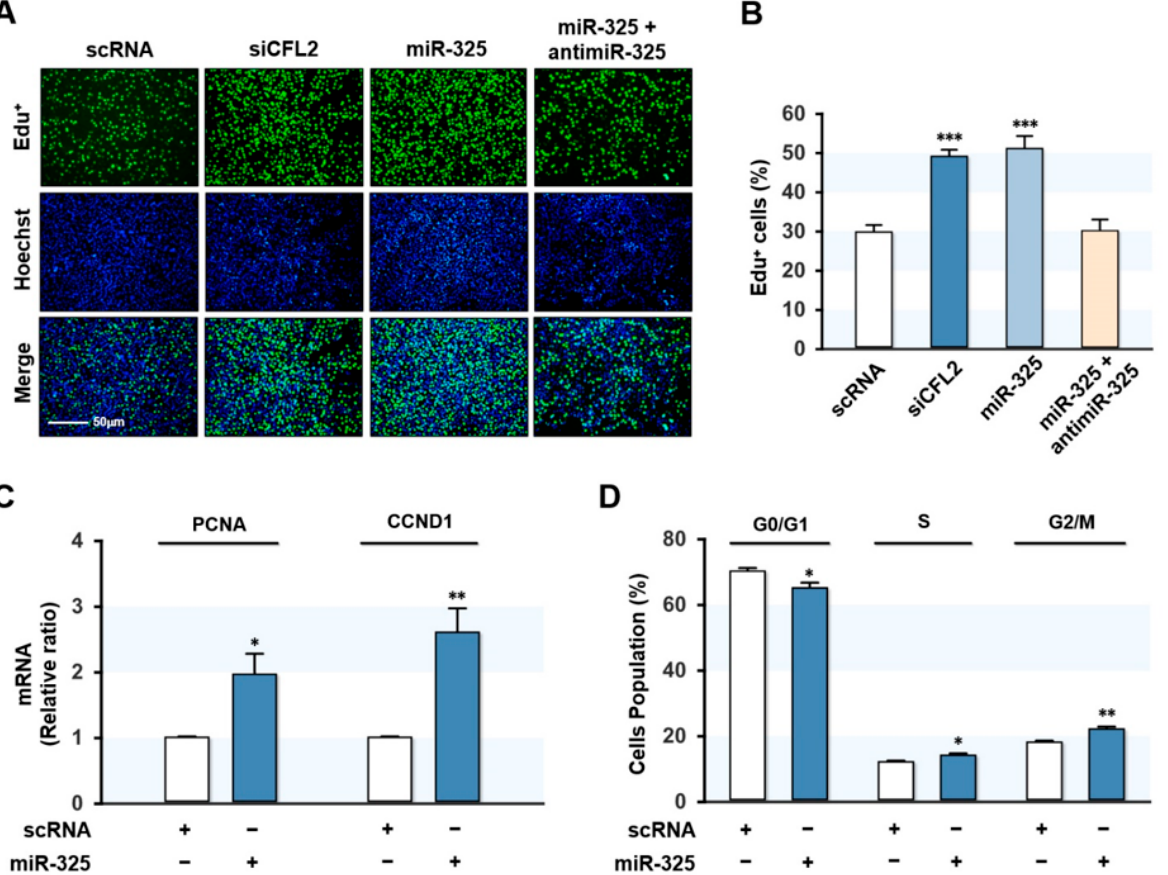
Figure 4. MiR-325-3p promoted myoblast proliferation and cell cycle progression. C2C12 cells were transfected with 200 nM of scRNA, siCFL2, miR-325-3p mimic (miR-325), or antimiR-325-3p (antimiR-325). ( A ) EdU assays were conducted 24 h after transfection. Cells undergoing DNA replication were labeled with EdU (green) and nuclei with Hoechst 33342 (blue). Scale bar: 50 μ m. ( B ) Percentages of EdU-positive cells were determined by the ImageJ program. ( C ) PCNA and CCND1 levels in C2C12 myoblasts were determined by q RT-PCR and normalized with U6. ( D ) Flow cytometry after 24 h of transfection with scRNA or miR-325-3p mimic. All results are presented as the means ± SEMs ( n > 3), and levels of significance are presented as *, p < 0.05; **, p < 0.01; ***, p < 0.001 vs. scRNA controls.